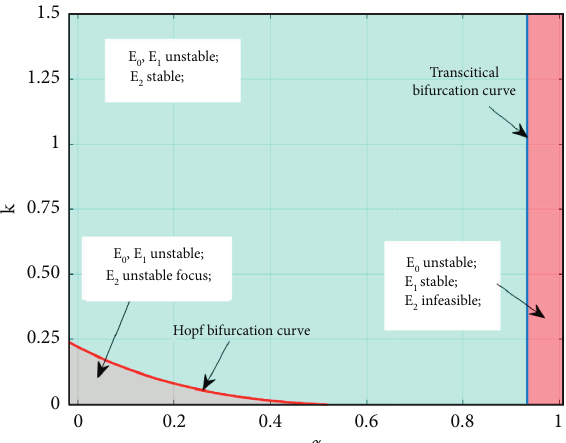
Figure 3: Stability regions of different equilibrium points of the model system (27) in α − k parametric plane. For lower values of α and k , both prey and predator populations oscillate and settle to a stable limit cycle. As the degree of habitat complexity crosses the lower threshold curve “Hopf bifurcation curve,” the system experiences a supercritical Hopf bifurcation. The coexistence steady state, E , remains stable; in 2 fact, globally asymptotically stability for the values of ( α ,k ) belongs to the light blue shaded region. A transcritical bifurcation occurs as the degree of habitat complexity crosses the critical threshold 􏽥 α � α [ tc ] � 0 . 9332. Other set of parameter values is taken as 􏼉